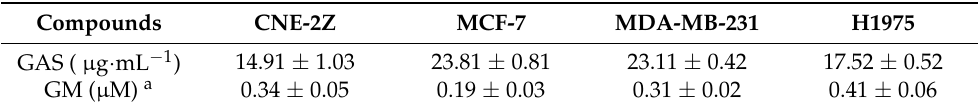
Table 2. Anti-proliferative activities (IC 50 ) of GAS in four human cancer